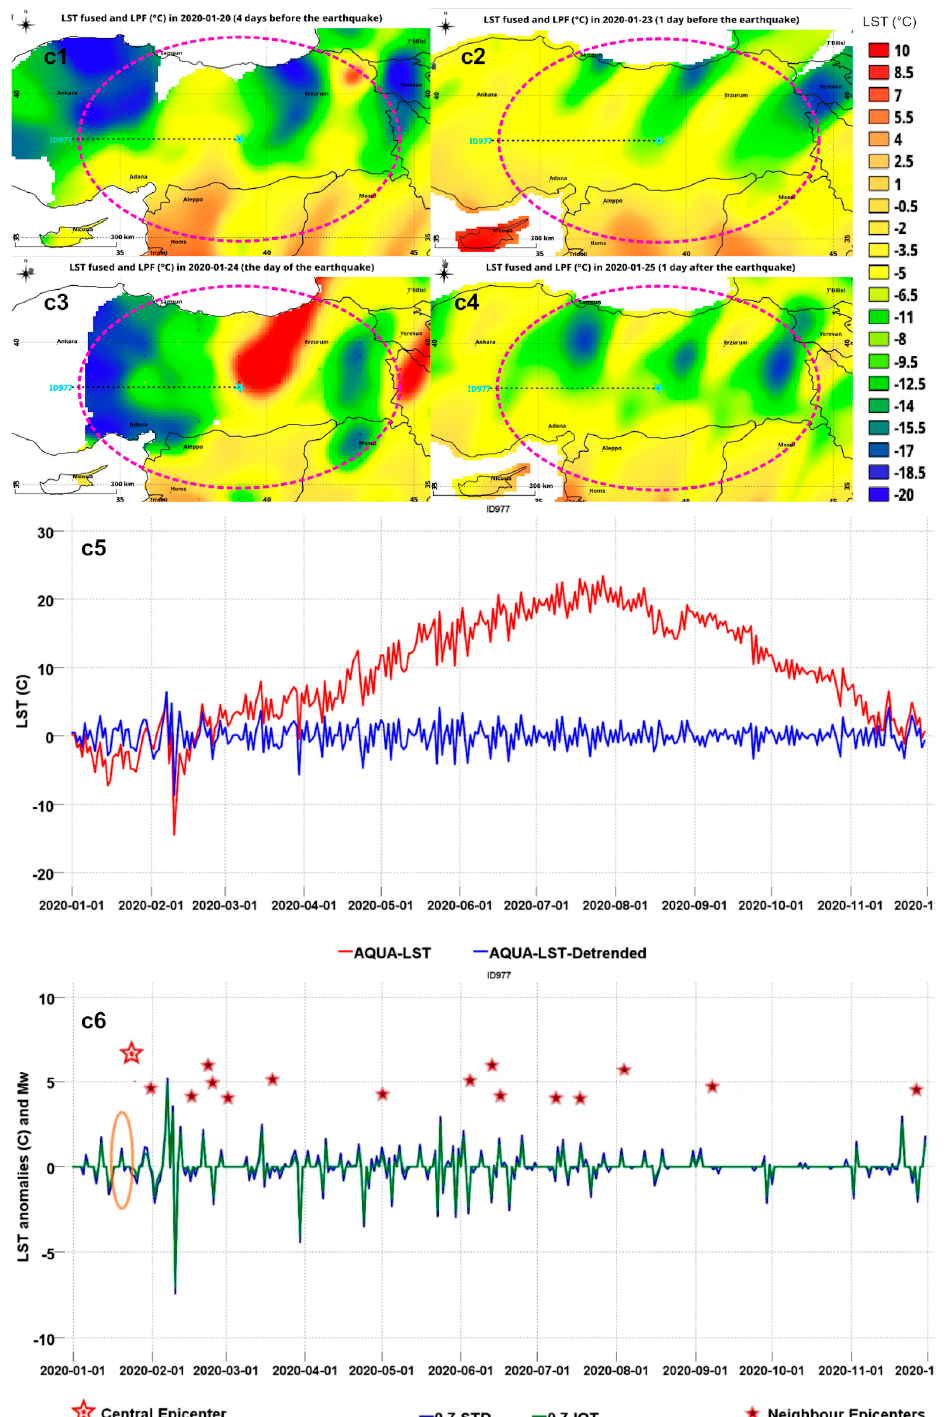
Figure 4. Sample LST maps, original, detrended, and anomalies time series (°C) measured with ABI/GOES or MODIS/AQUA for epicenters ( a1 – a6 ) ID5086, ( b1 – b6 ) ID9629, and ( c1 – c6 ) ID977 in 2020.